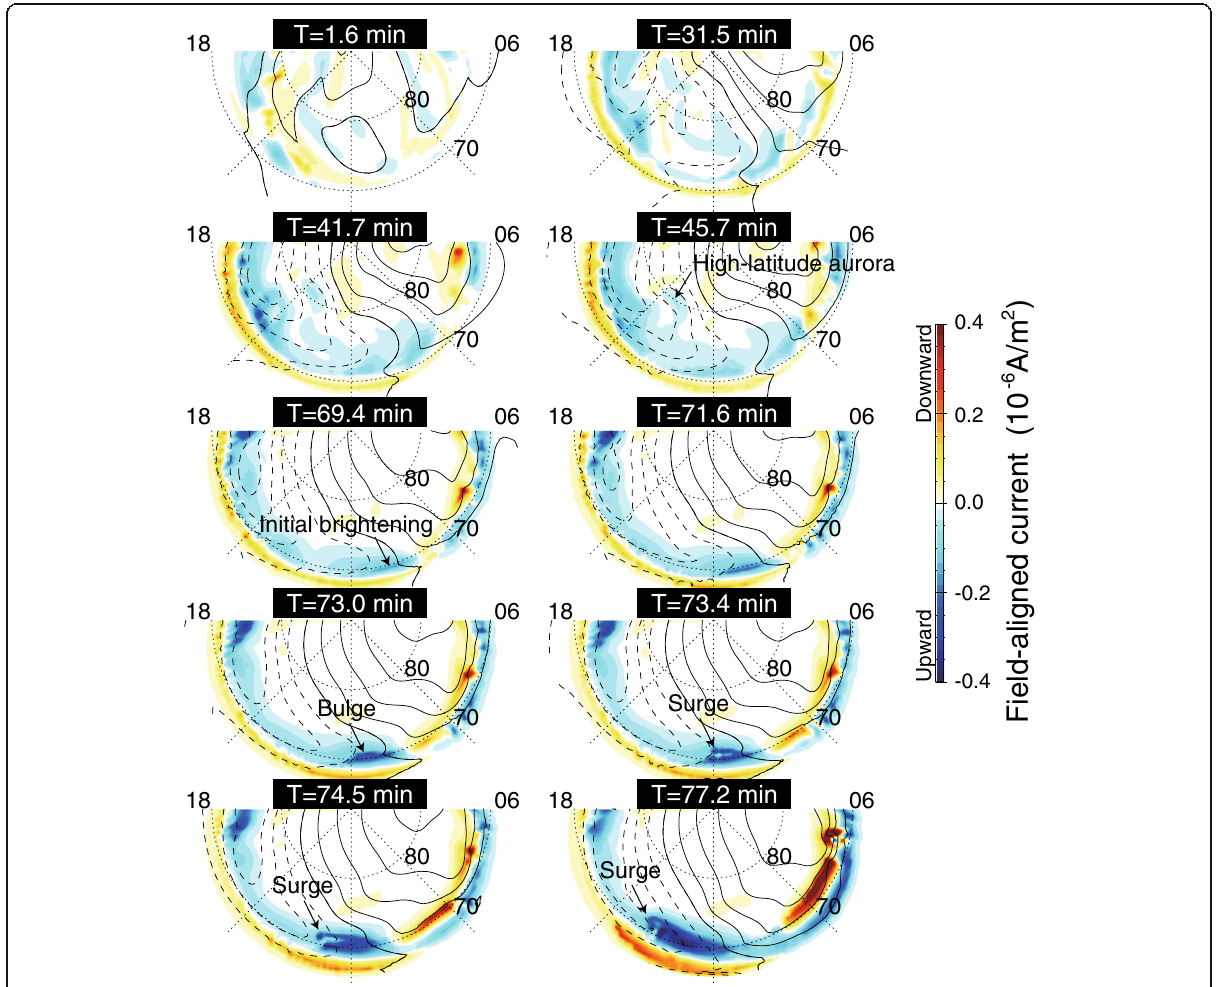
Fig. 2 Field-aligned current in the ionosphere (negative upward). The contour line indicates the ionospheric electric potential at an interval of 5 kV. The solid and dashed lines indicate the positive and negative potentials, respectively. The Sun is towards the top. The lower boundary is located at 65 magnetic latitudes (MLATs). (Adapted from Ebihara and Tanaka